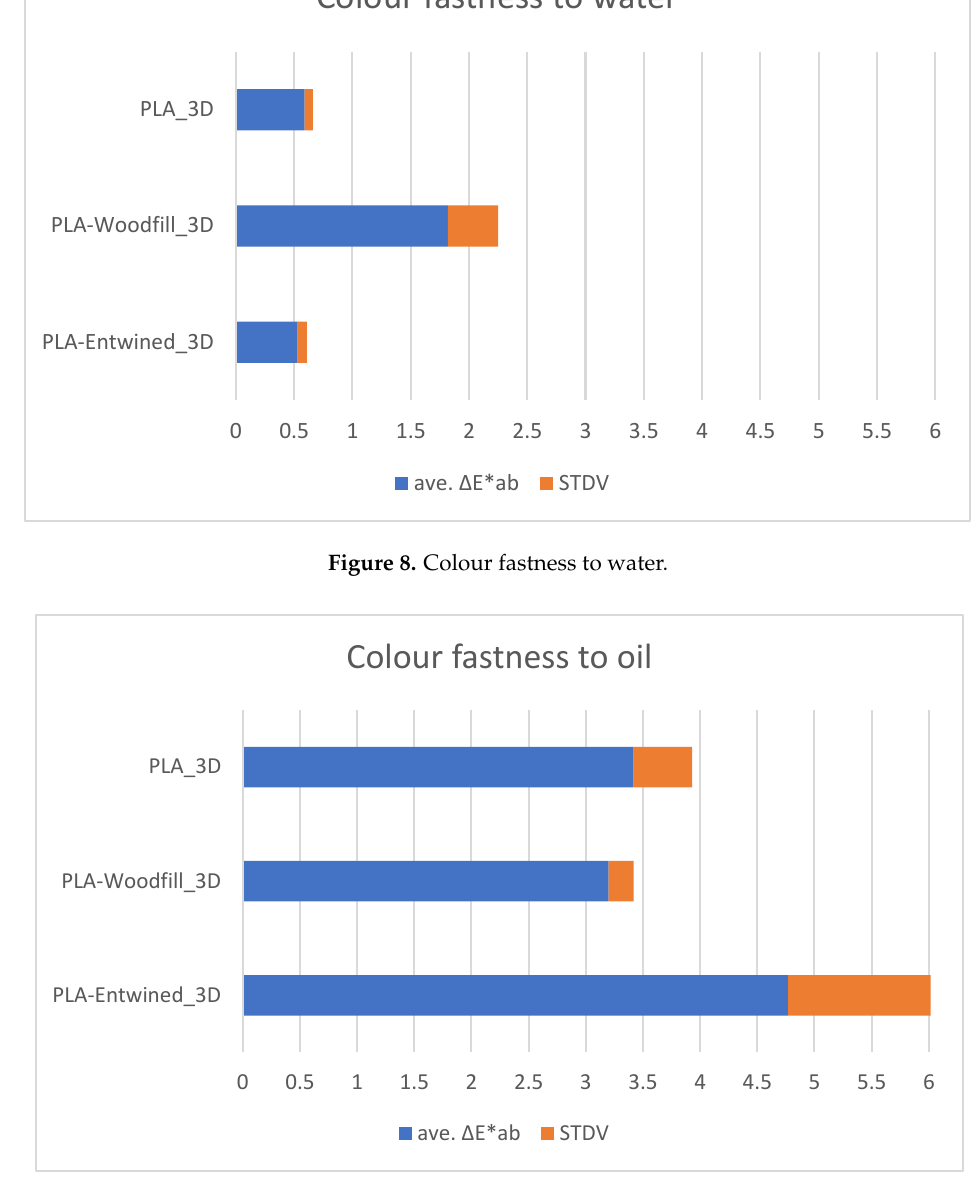
Figure 9. Colour fastness to oil.